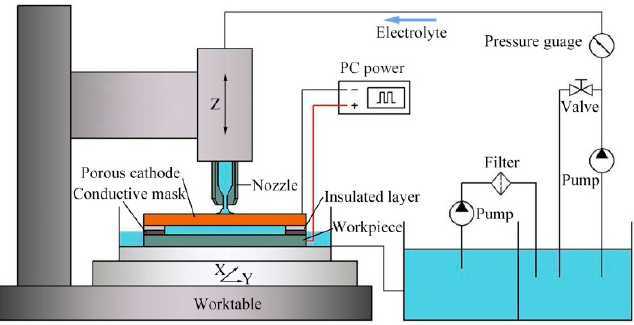
Figure 6. Schematic of an experimental system.